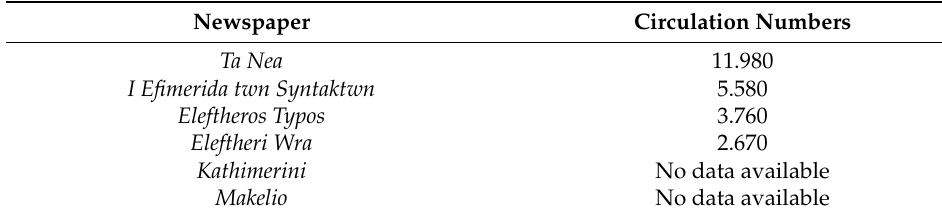
6 Table 1. News sites ranking (according to Alexa ranking 3 December 2020). Rank